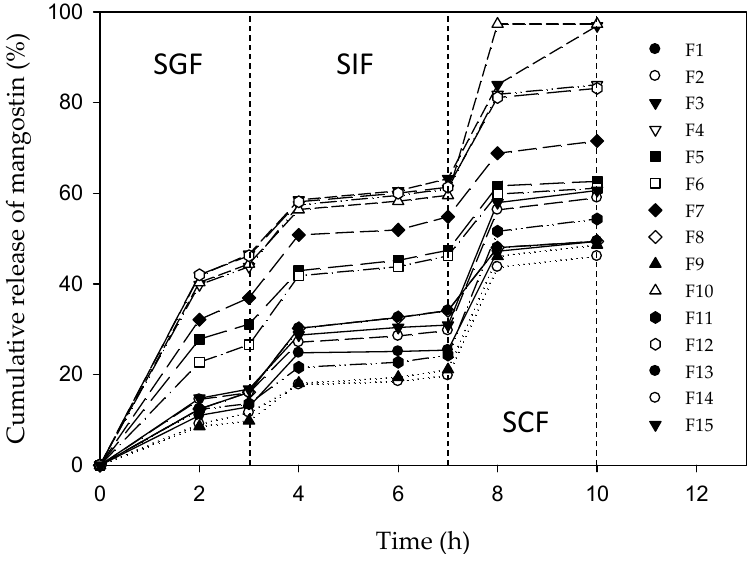
Figure 2. Release profile of alpha mangostin from chitosan–alginate microparticles (0–3 h in simulated gastric fluid (SGF), 3–7 h in simulated intestinal fluid (SIF), and 7–10 h in simulated colonic fluid (SCF)).